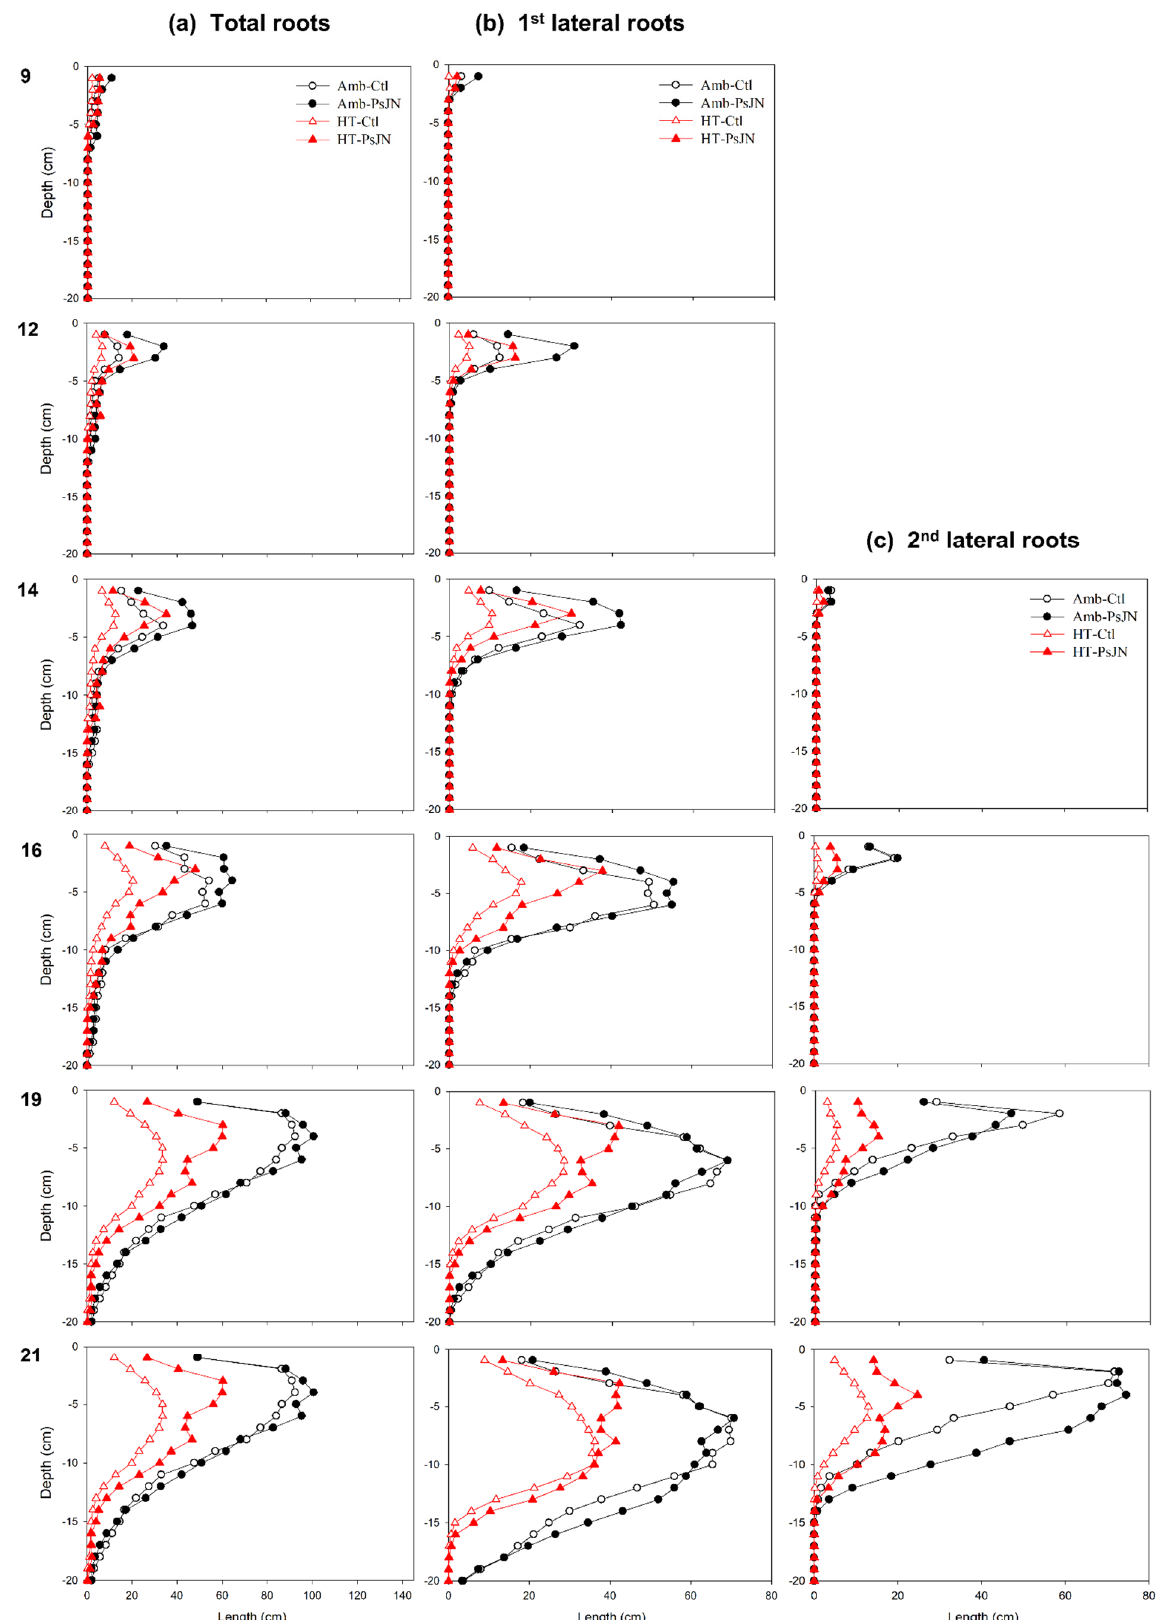
Figure 4. Root length distribution across different depths through time. Length distribution of plant roots from all of the treatments across different depths or layers (20 horizontal sections)